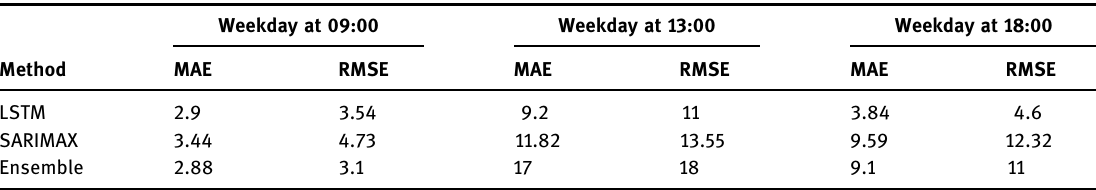
Table 7: Evaluation of algorithms without visitor trend data on a weekday Weekday at 09:00 Weekday at 13:00 Weekday at 18:00